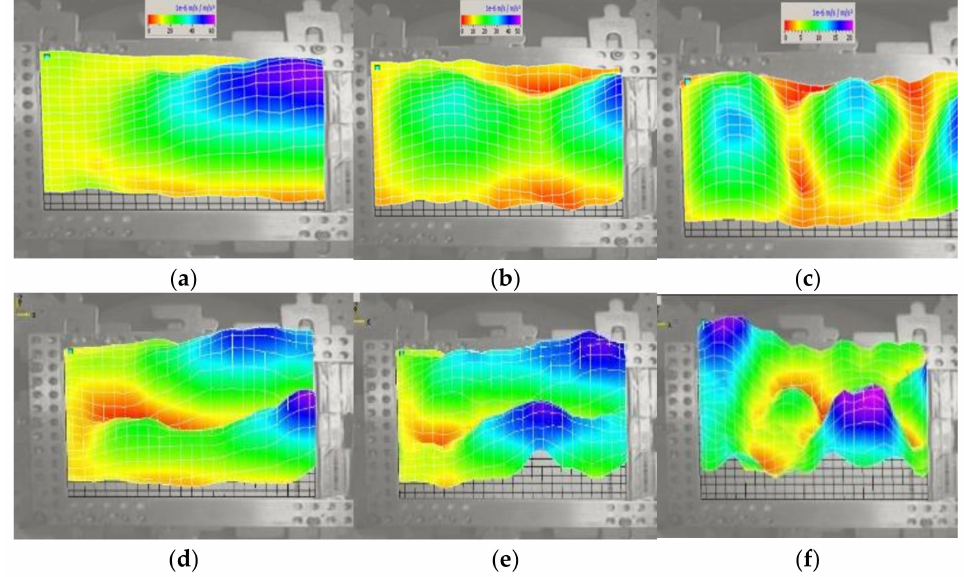
Figure 7. Pouch LIB mode shapes for boundary condition 1 shown in Figure 4a. ( a ) mode shape 1–first bending, ( b ) mode shape 2–first torsion, ( c ) mode shape 3–second torsion, ( d ) mode shape